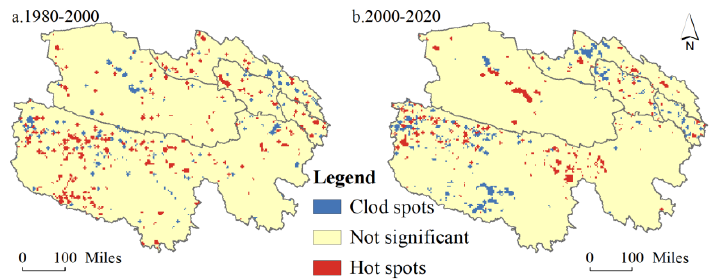
Figure 7. Spatial distribution effects of cold/hot spots on elasticity of ESV change.